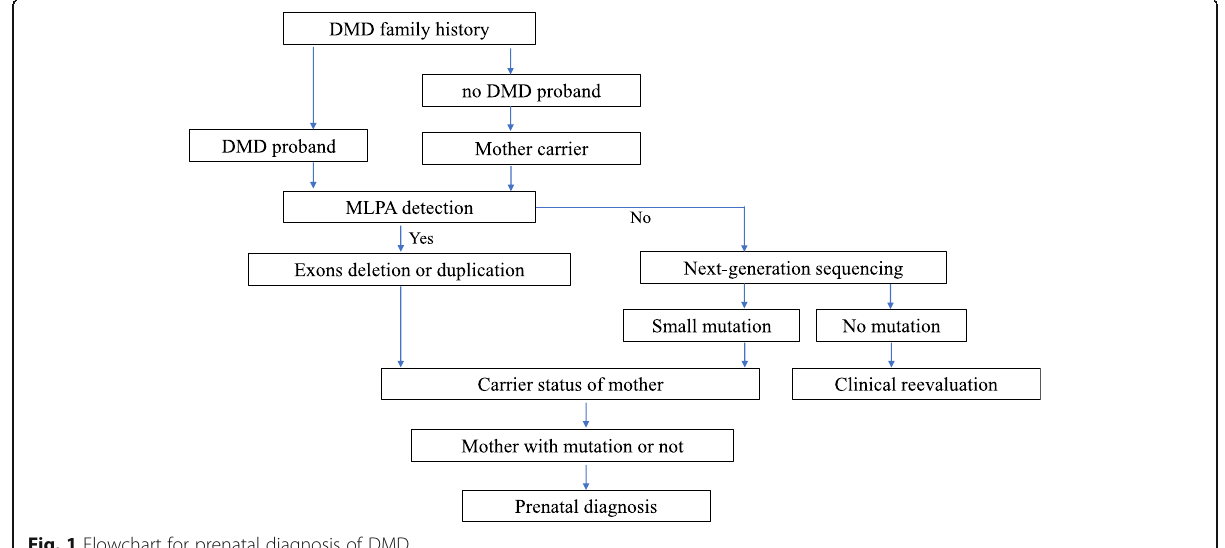
Fig. 1 Flowchart for prenatal diagnosis of